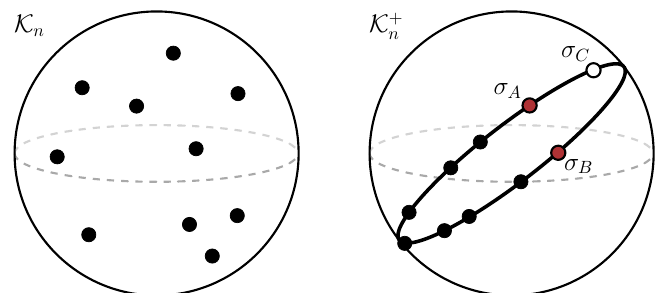
Figure 1 . From CP 1 to RP 1 . Left: generic kinematics, leads to con(cid:12)gurations of punctures K n + living on a Riemann sphere. Right: positive kinematics, makes the punctures arrange themselves n K on a real projective line. The black punctures (cid:27) 1 ; (cid:27) 2 ; : : : ; (cid:27) n (cid:0) 3 can be thought of as a system of mutually repelling particles on the interval I = [ (cid:27) A ; (cid:27) B ]. Punctures (cid:27) A ; (cid:27) B ; (cid:27) C can be (cid:12)xed using SL(2 ; R ) invariance. The (cid:12)rst two then provide repelling boundary conditions for the black particles. space of such matrices is n ( n 3) = 2-dimensional and will be denoted by n . In dimensions (cid:0) K d < n 1 there are extra constraints on the minors of the (cid:0)